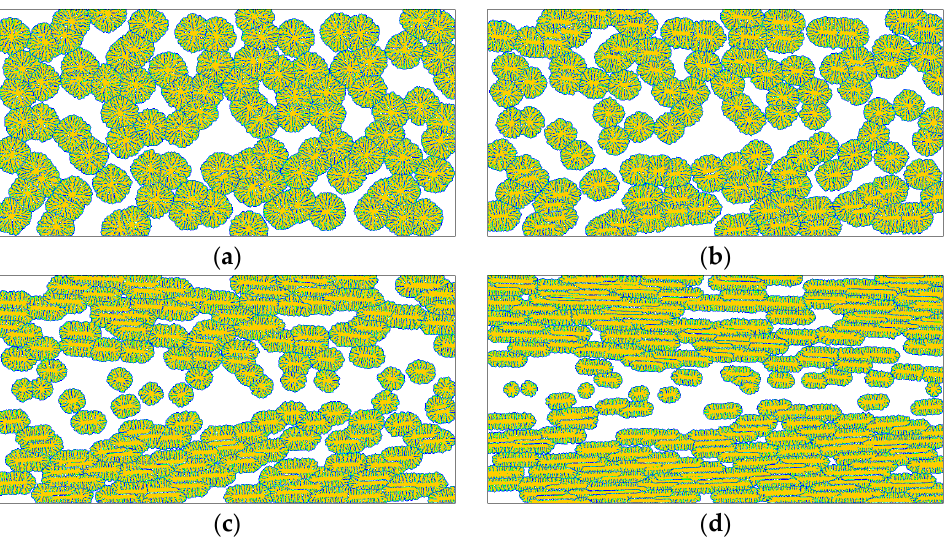
Figure 10. Simulated crystallization morphologies in the crystal order parameter field for different flow strength without considering the interface anisotropy but with introducing a relatively big noise ( A = 0.1): ( a ) ˆ γ “ 1.0, t “ 1000; ( b ) ˆ γ “ 10, t “ 800; ( c ) ˆ γ “ 30, t “ 600; ( d ) ˆ γ “ 100, t “ 400. Here the time instants are chosen to ensure the results show similar sizes of crystallized regions.